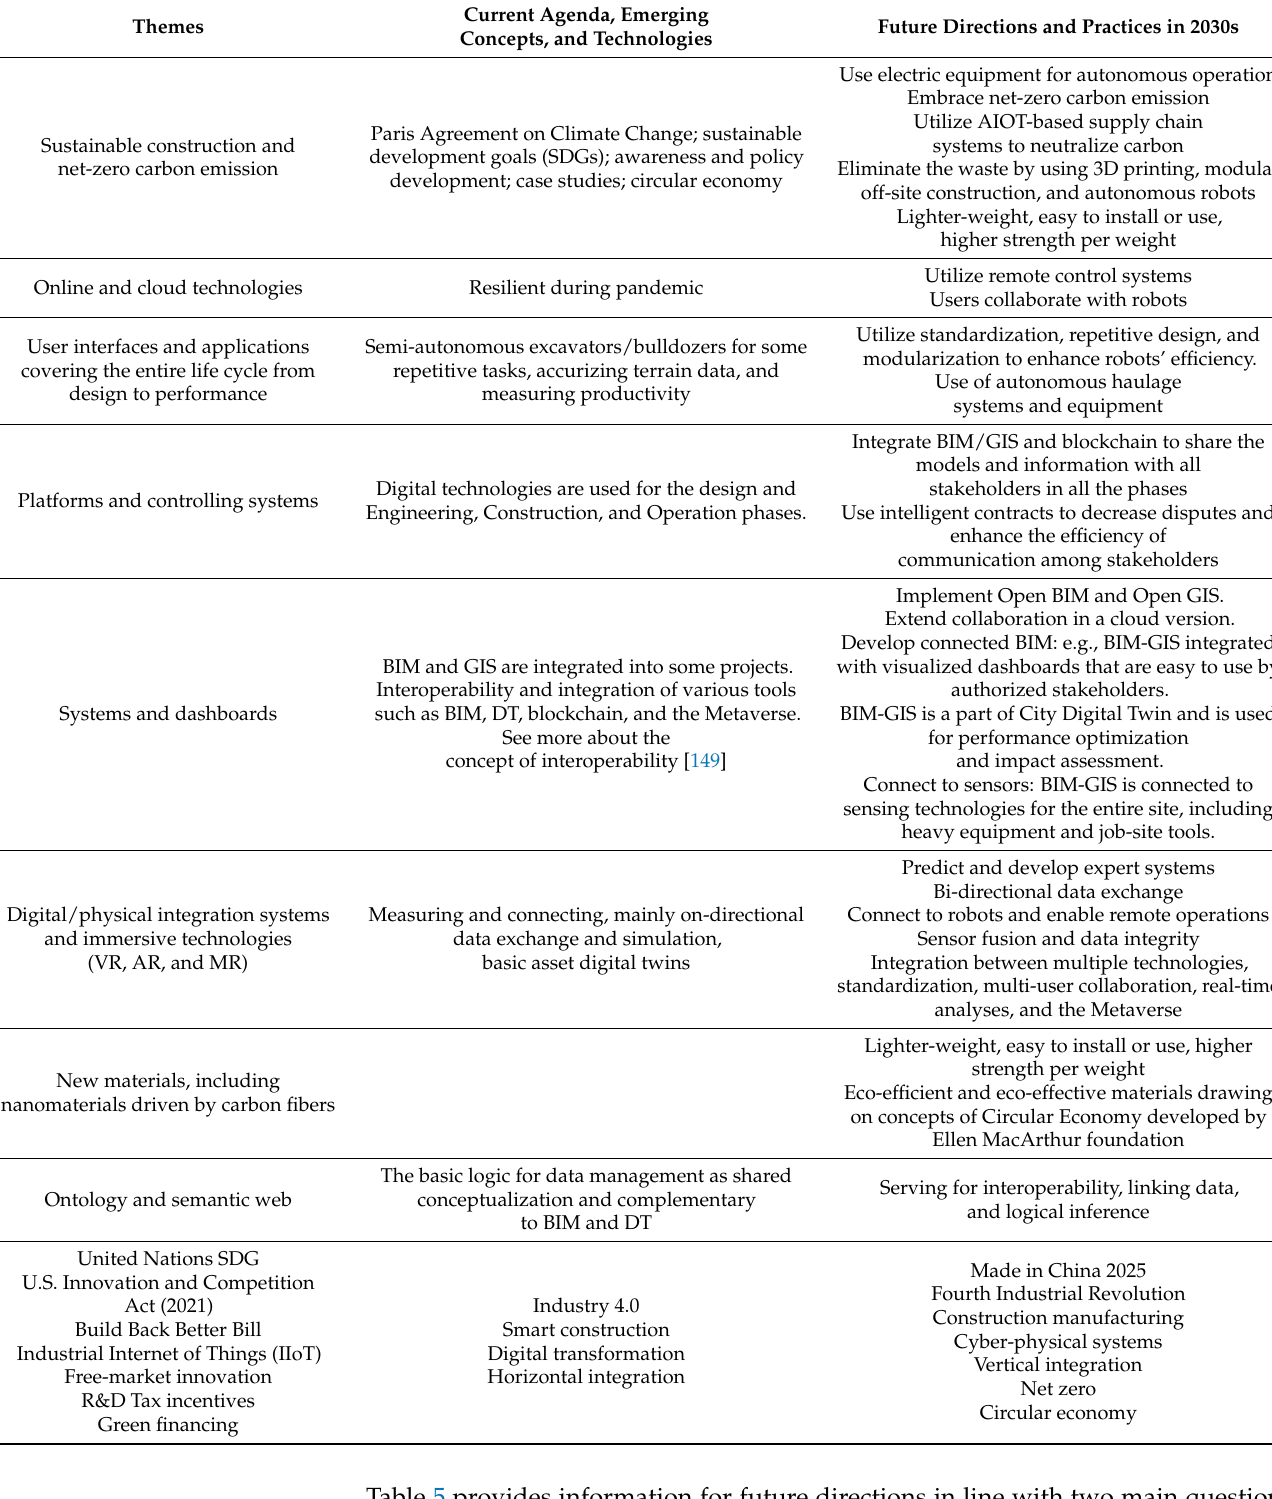
Table 5. Suggestion for future studies based on a summary of potential solutions at the horizon of